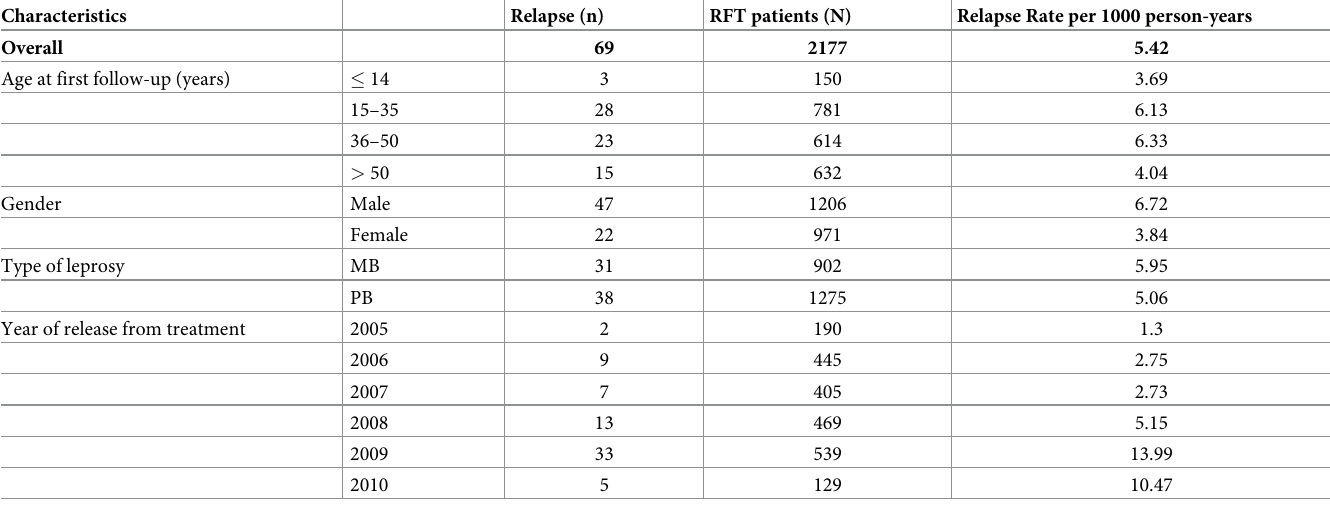
Table 2. Number and incidence of relapse (per 1000 person-years) among the RFT patients: Relapse and deformity among patients released from National Leprosy Eradication Programme of India: A cohort study from four districts in South India.